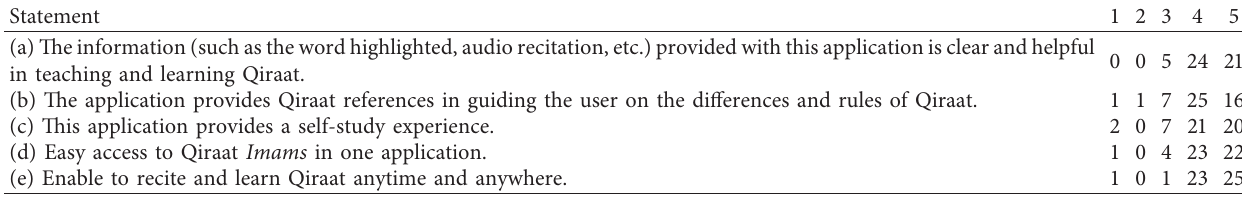
Figure 10: Help page. Table 2: Statement on research question one.